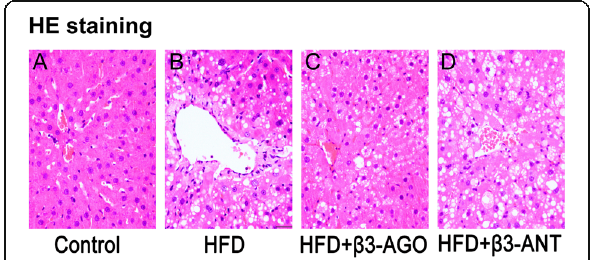
Fig. 2 Histological changes in the liver in the control, HFD, HFD + β 3-AGO and HFD + β 3-ANT groups (each group, n = 8). a The control group showed normal liver histological features, and the hepatocytes were arranged in an orderly manner. b In the HFD group, prominent hepatic steatosis, inflammation and ballooning degeneration were observed. c In the HFD + β 3-AGO group, significantly improved structural changes with limited hepatic steatosis, inflammation and ballooning degeneration were observed. d The image for the HFD + β 3-ANT group shows several scattered balloon cells that are much larger than the surrounding steatotic hepatocytes, in sharp contrast to the normal hepatocytes in the image in ( a ). The magnification is 200